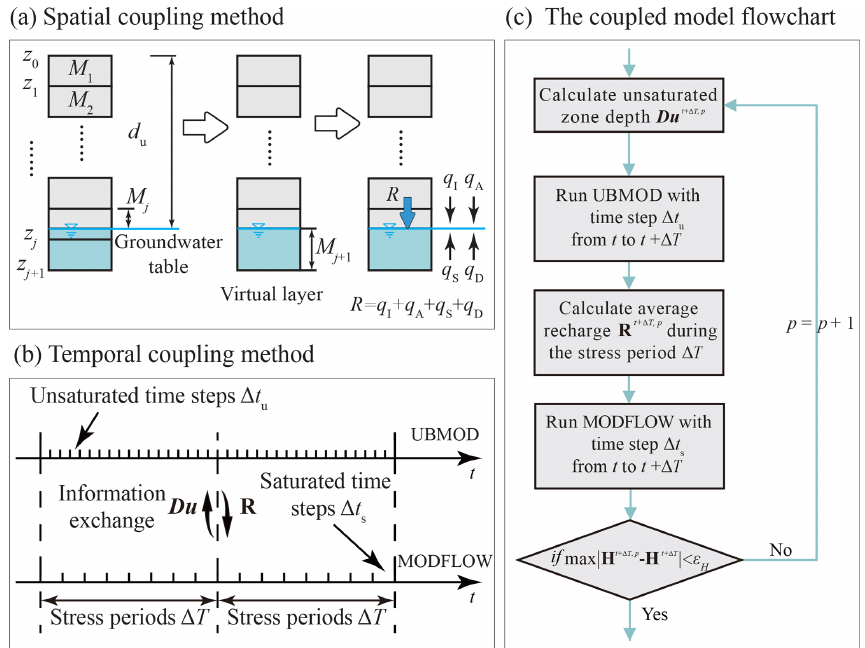
Figure 2. (a) The spatial coupling scheme for one saturated cell and one unsaturated soil column. (b) The temporal coupling scheme and the relationship between the stress period ( (cid:49)T ) and the time steps for UBMOD ( (cid:49)t u ) and MODFLOW ( (cid:49)t s ). (c) The specific implementation of the iterative coupling scheme from t to t + (cid:49)T . Note: z i ( i = 1,..., j ) is the vertical elevation of layer i ; d u is the thickness of the unsaturated zone; M i is the thickness of layer i ; R is the groundwater recharge for one cell; q I , q A , q S , and q D are the fluxes across the water table caused by allocation of the infiltration water, the advective movement, source/sink terms, and the water diffusion per unit area, respectively; Du is the thickness of the unsaturated zone ( l dimension); R is the vertical net recharge for the regional scale ( m × n dimension); t is the time; p is the iteration level; H is the saturated hydraulic head ( m × n dimension); ε H is a user-specified